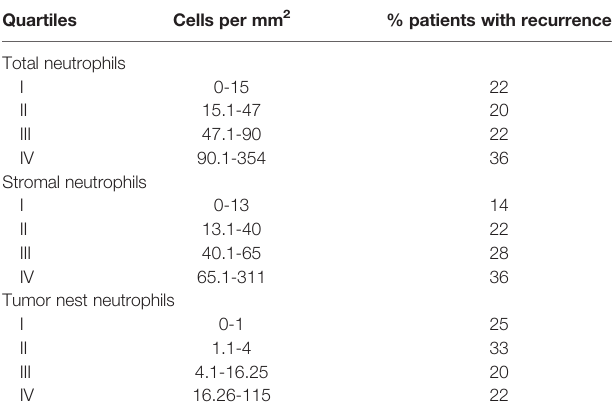
TABLE 3 | Baseline characteristics of patients with low- and high-density stromal